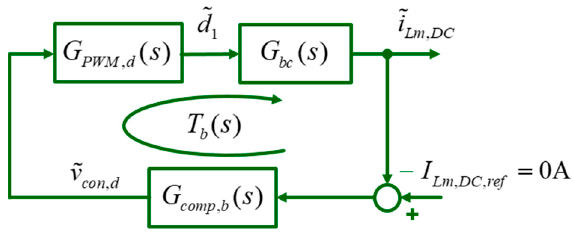
Figure 13. Control block diagram of the flux-balance loop.